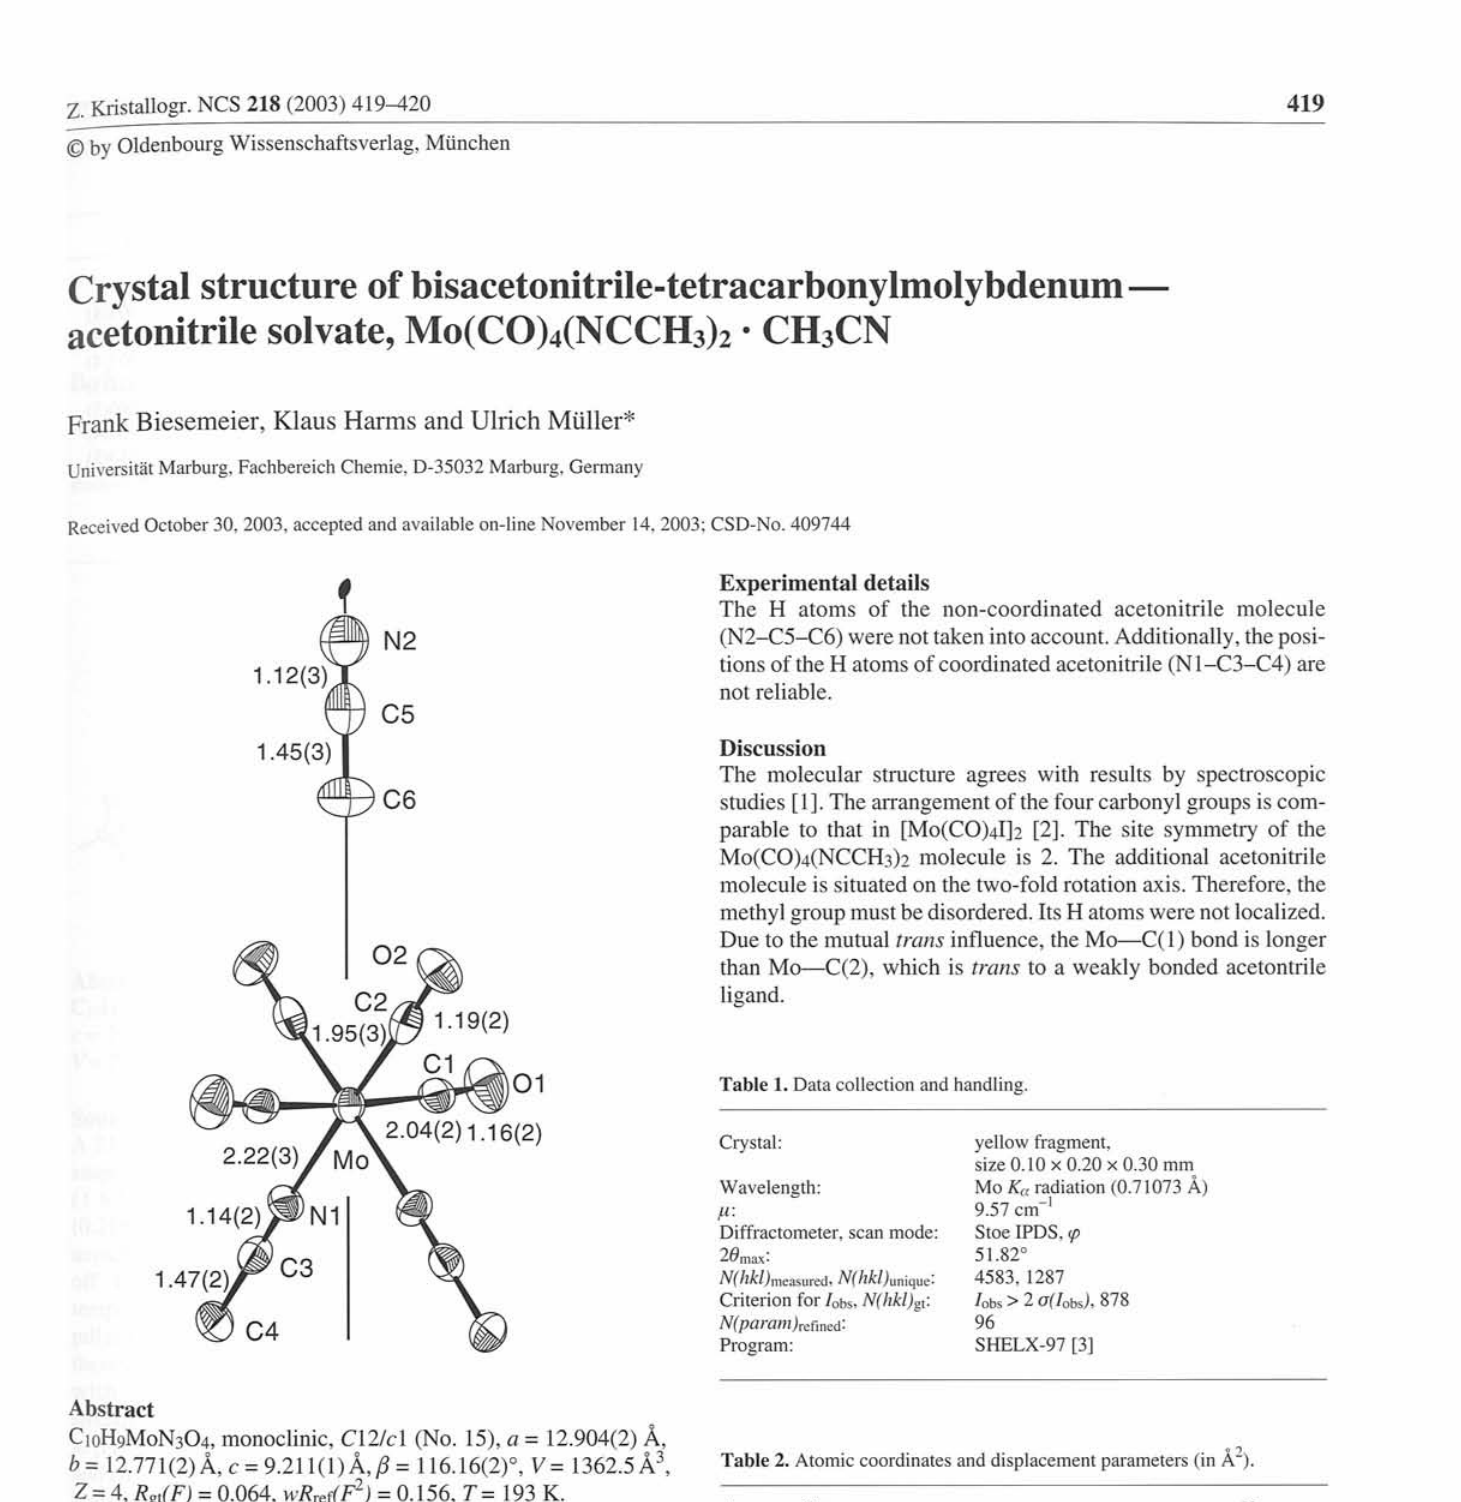
Table 2. Atomic coordinates and displacement parameters (in